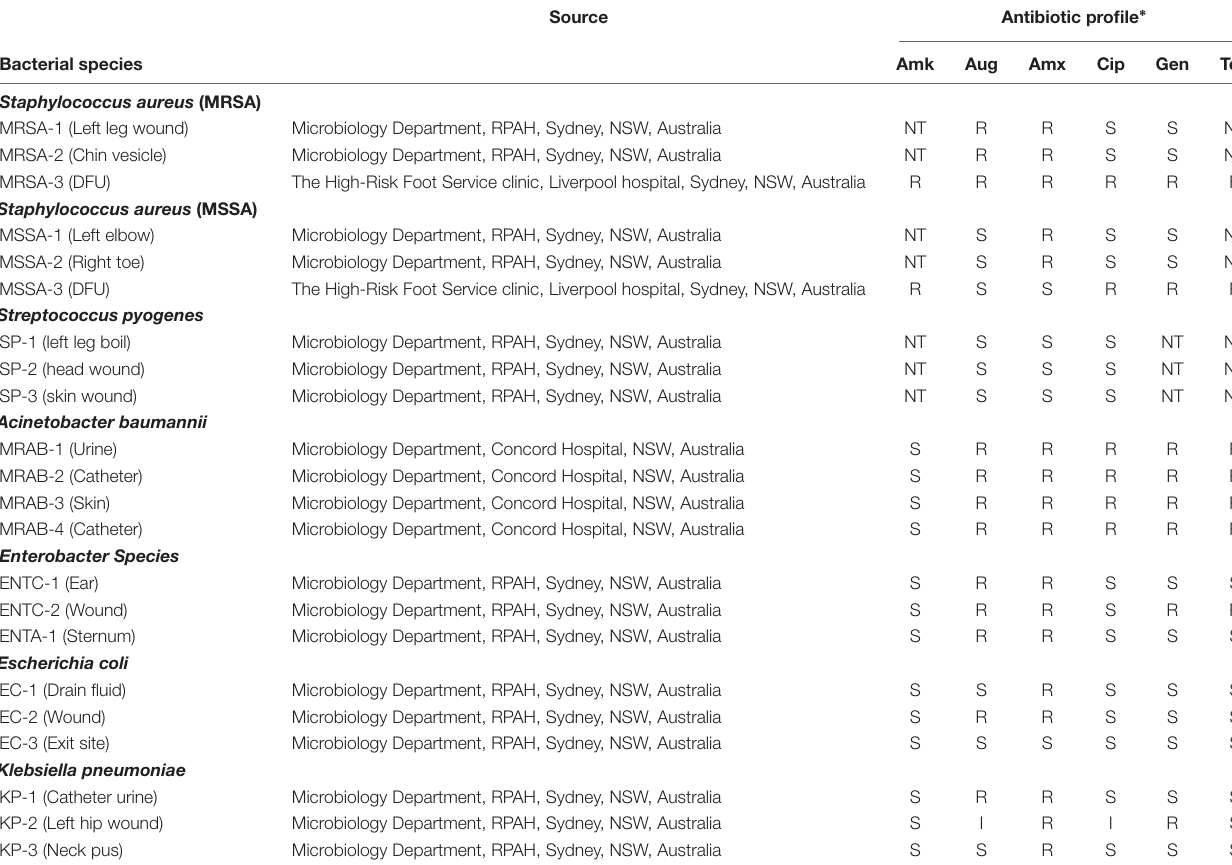
TABLE 1 | Source and antibiotic profile of bacterial species/strains obtained from hospital culture collections.